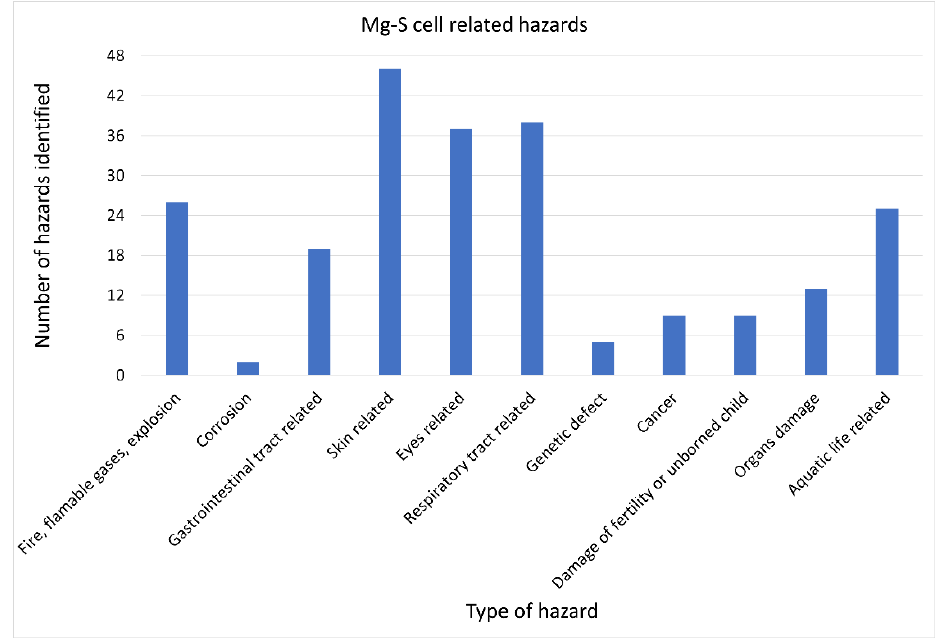
Figure 12. The number of the hazards identified versus the type of hazard for materials in Mg–S cells.